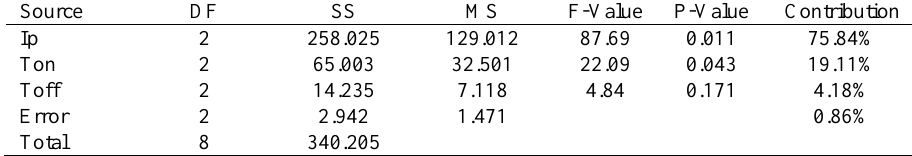
Table 6. ANOVA for S/N ratio of Cu-Gr electrode material removal